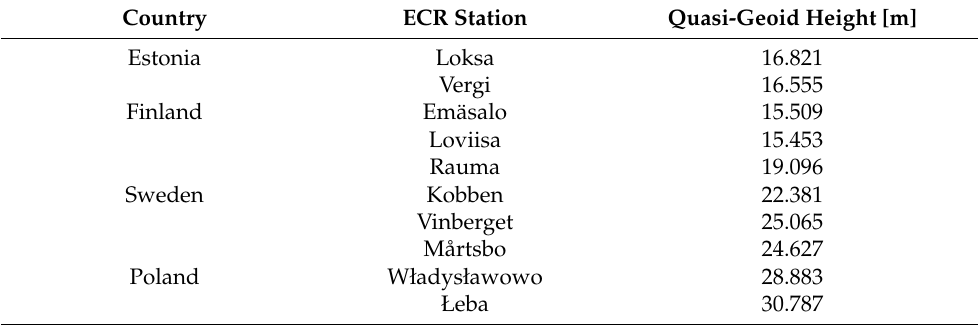
Table 8. Final quasi-geoid heights for the Baltic Sea ECR stations at epoch 2020.5. Unit: